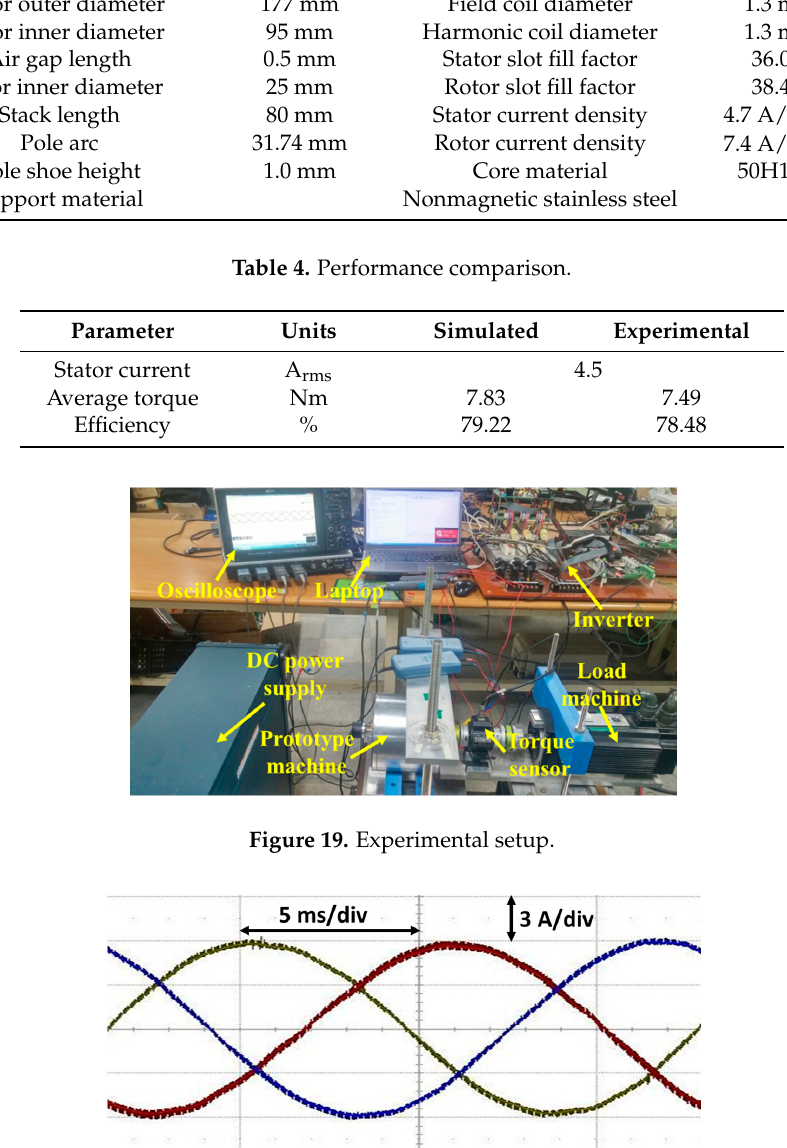
Figure 21. Experimental analysis: torque at synchronous speed. 6. Conclusions This paper presents the optimal design of the BL ‐ WRSM using a special stator ‐ winding arrangement to improve the output torque and reduce the torque ripple. The torque ripple of the machine is decreased by optimizing the pole shape of the rotor with the aid of finite element method and optimization techniques including the Kriging method and a genetic algorithm. The torque output was improved by optimizing the harmonic winding of the machine. The torque of the optimal model was improved by 7.55% and torque ripple was decreased by 61.6% as compared to those of the basic model. Moreover, any application requiring a speed range as much as 1 to 4.17 can benefit from this machine design. The experimental test of the optimal motor reveals the output torque within 4.5% error and torque ripple within 3.2% error at the synchronous speed of 900 rpm, which verifies the simulation results. Acknowledgments: This work was supported in part by the Human Resources Program in Energy Technology of the Korea Institute of Energy Technology Evaluation and Planning (KETEP), granted financial resource from the Ministry of Trade, Industry & Energy, Republic of Korea. (No. 20154030200730), and in part by the BK21PLUS Program through the National Research Foundation of Korea within the Ministry of Education. Author Contributions: Asif Hussain proposed the idea, perform the optimization and simulation analysis and wrote the manuscript. Shahid Atiq cooperated to perform the experiment and Byung ‐ il Kwon supervised the research throughout. Conflicts of Interest: The authors declare no conflicts of interest. References 1. Lipo, T.A.; Du, Z.S. Synchronous motor drives ‐ a forgotten option. In Proceedings of the 2015 International Aegean Conference on Electrical Machines & Power Electronics (ACEMP), 2015 International Conference on Optimization of Electrical & Electronic Equipment (OPTIM) & 2015 International Symposium on Advanced Electromechanical Motion Systems (ELECTROMOTION), Side, Turkey, 2–4 September 2015; pp. 1–5. 2. Cheng, M.; Hua, W.; Zhang, J.; Zhao, W. Overview of Stator ‐ Permanent Magnet Brushless Machines. IEEE Trans. Ind. Electron. 2011 , 58 , 5087–5101, doi:10.1109/TIE.2011.2123853.